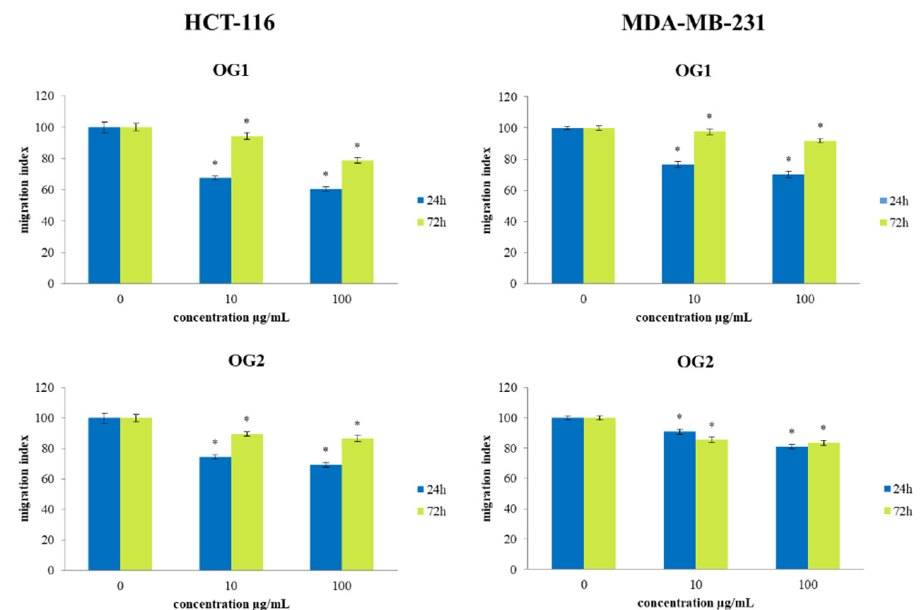
Figure 8. Effect of exposure to investigated essential oils OG1 and OG2 on migration index of HCT- 116 and MDA-MB-231 cells. The cells were treated at concentrations of 10 µ g/mL and 100 µ g/mL during 24 h and 72 h exposure compared to nontreated control cell. Results are presented as the mean of three independent experiments ± standard error; * p < 0.05 relative to control.